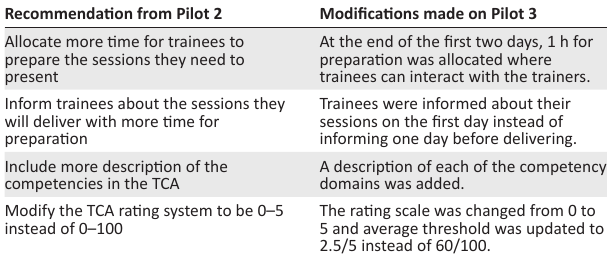
TABLE 5: Modifications made during the second pilot based on the first pilot feedback.